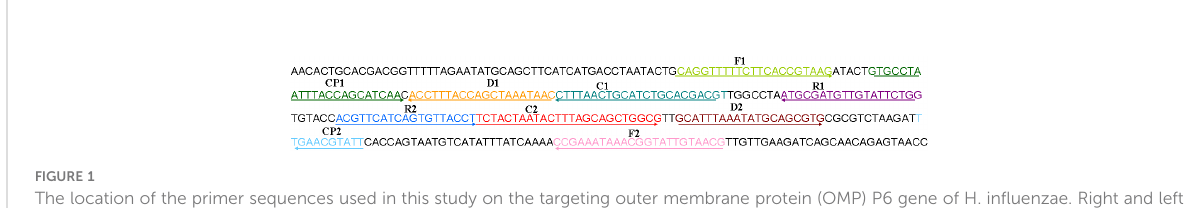
FIGURE 1 The location of the primer sequences used in this study on the targeting outer membrane protein (OMP) P6 gene of H. in fl uenzae. Right and left arrows show sense and complementary sequences, respectively. The colored text indicates the position of primers, including two displacement primers (F1 and F2), two cross primers (CP1 and CP2), and six ampli fi cation primers (C1, C2, D1, D2, R1, and